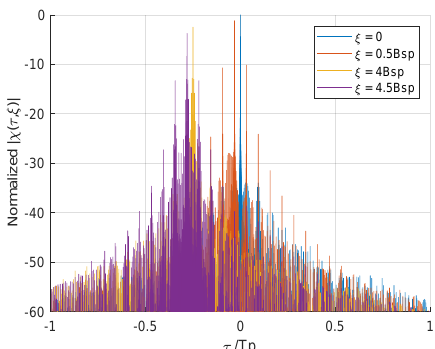
Figure 5. Comparison of different Doppler profiles in RSF-LS-DFC.